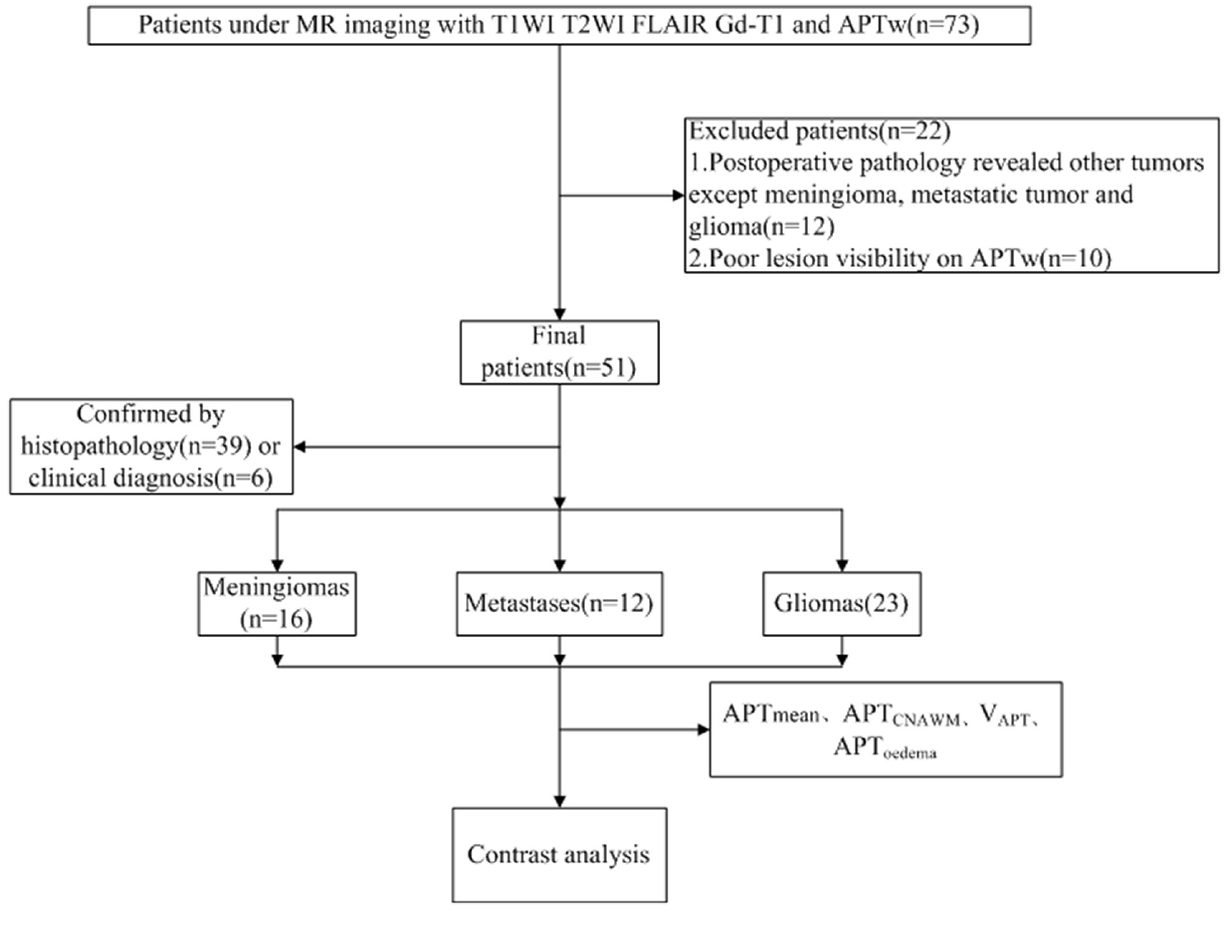
FIGURE 1 | A flow diagram of the patient selection process.